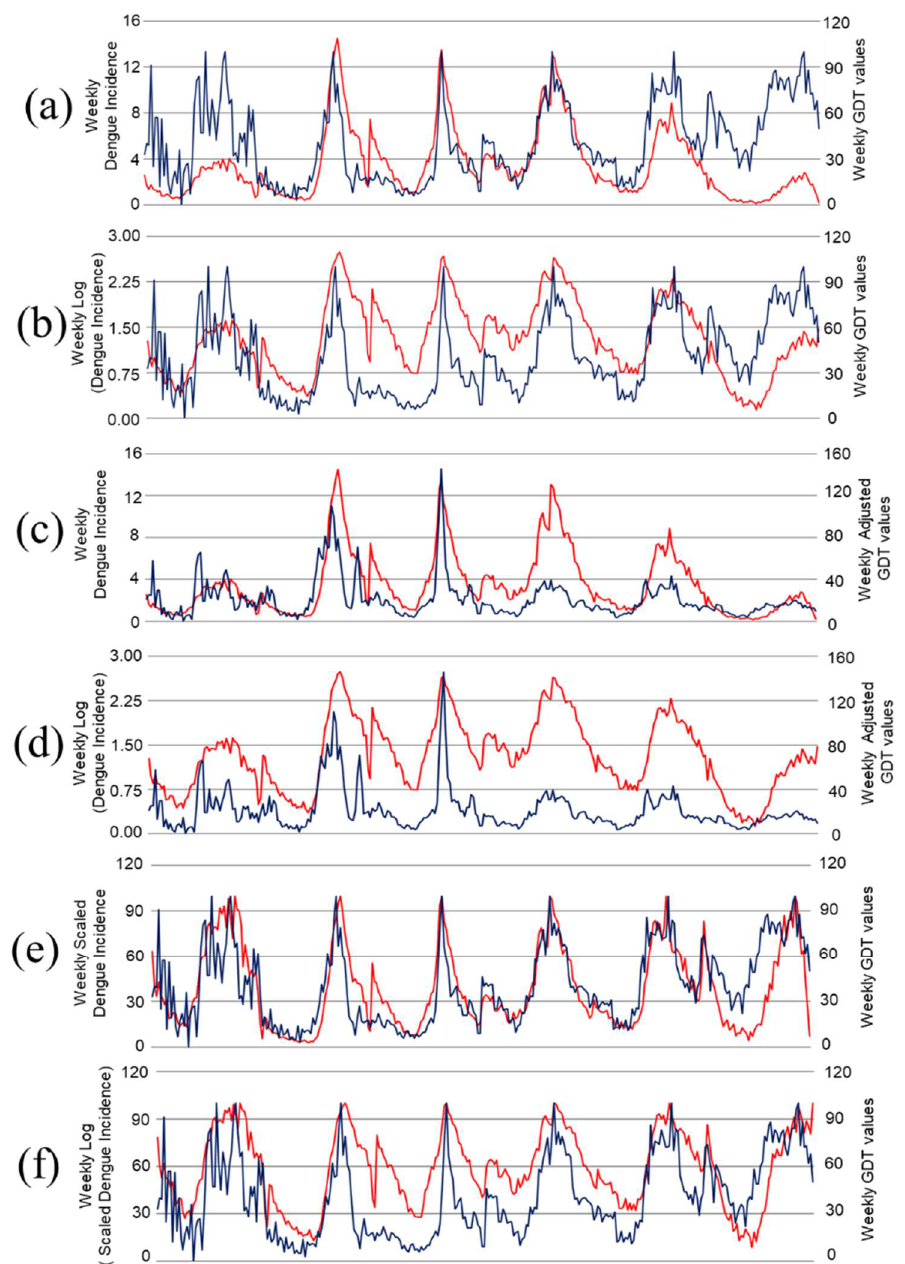
Figure 2. Weekly reports of dengue (red line) and Google Dengue Trends (GDT) (blue line) from 2009–2014. ( a ) Dengue incidence (DI) and GDT values; ( b ) log-transformed dengue incidence and GDT values; ( c ) dengue incidence and adjusted GDT values; ( d ) log-transformed dengue incidence and adjusted GDT values; ( e ) scaled dengue incidence and GDT values; ( f ) log-transformed scaled dengue incidence and GDT values .